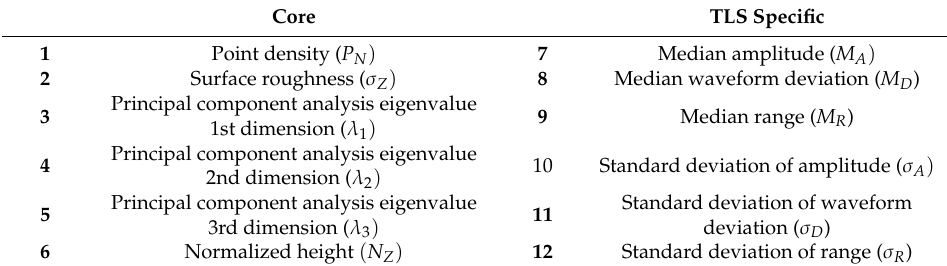
Table 2. Summary of core and TLS specific sets of inputs /